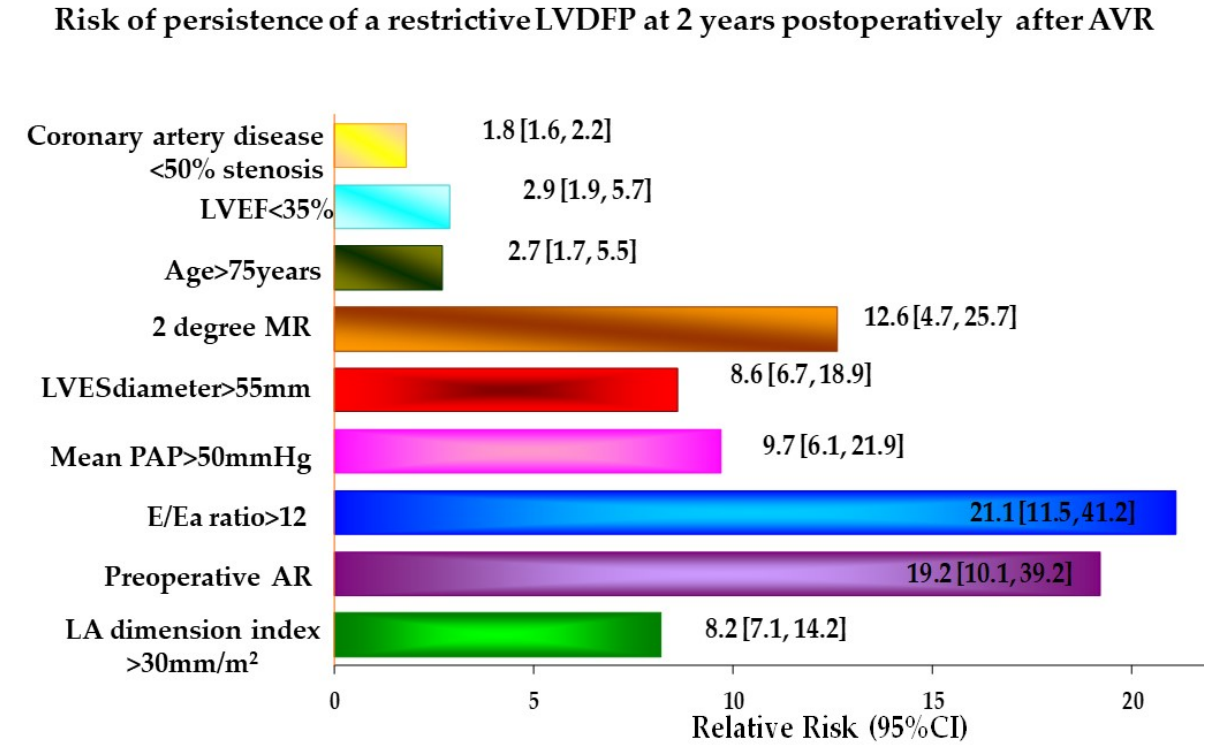
Figure 5. Risk of persistence of a restrictive LVDFP at 2 years postoperatively after AVR.